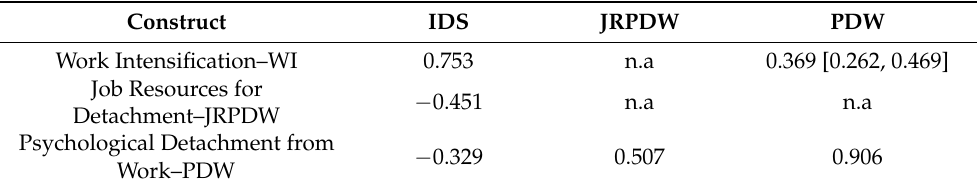
Table 5. Discriminant validity of the measurement model.